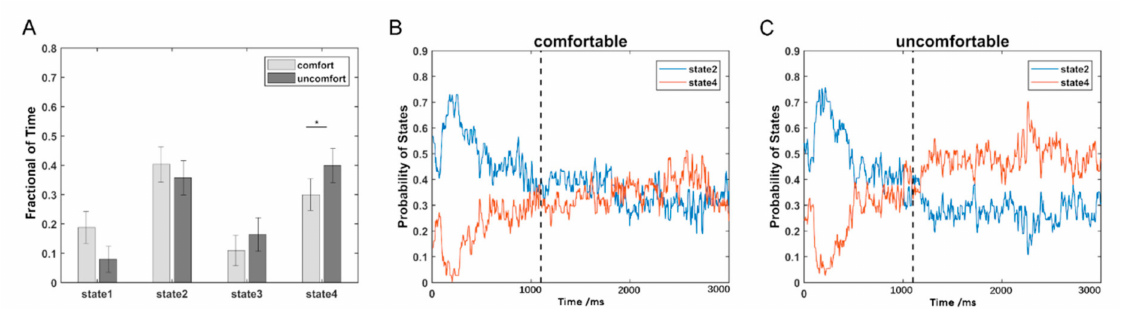
Figure 2. FC patterns of the four brain states for the visual comfort and discomfort conditions.